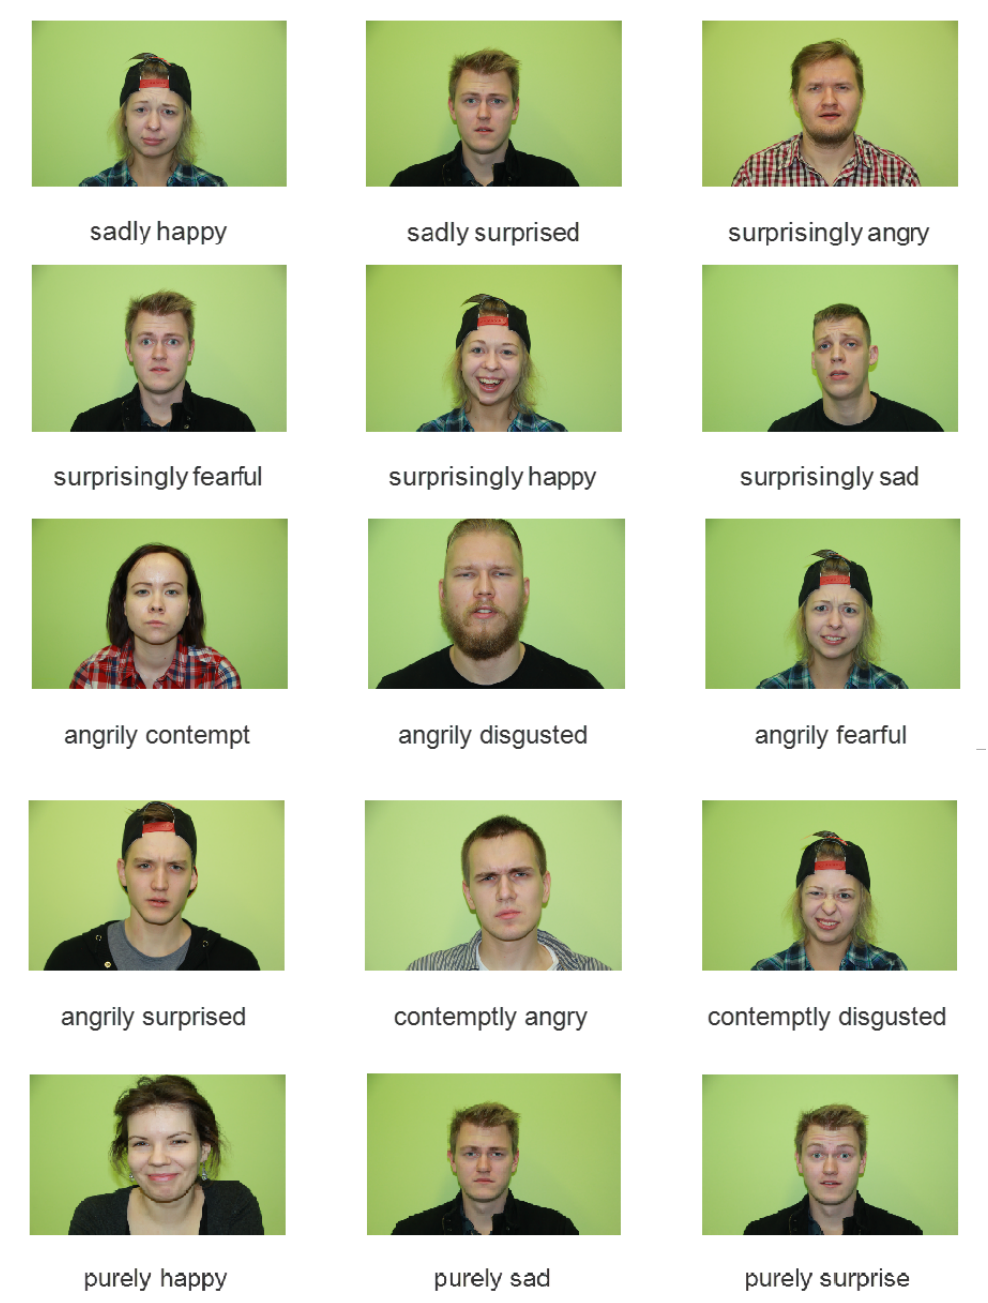
Figure 1. Some example emotions from the